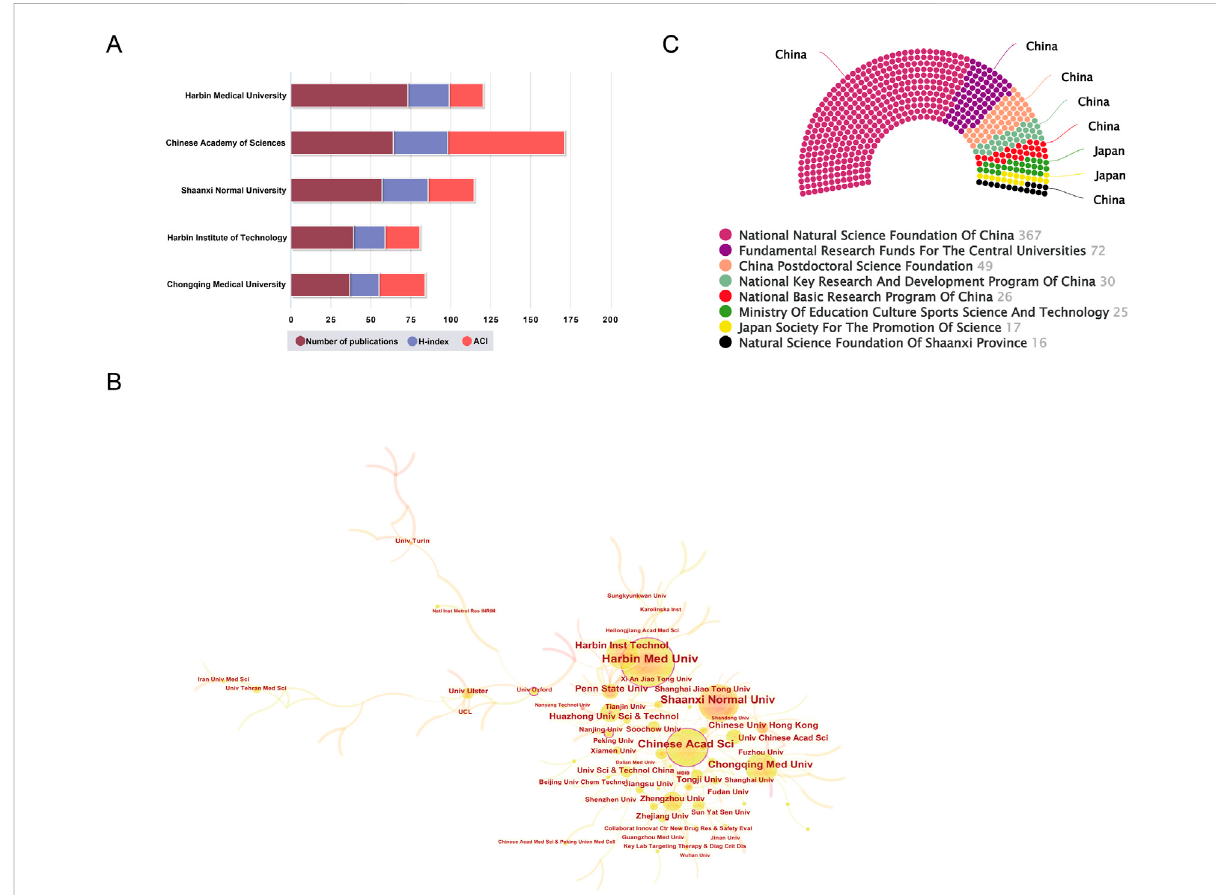
FIGURE 3 (A) The top fi ve most proli fi c institutions. (B) Institutional cooperation analysis by using CiteSpace. In this network map, each node represented an institution, and the node size represented their relative quantity of research outputs. A node with a purple circle showed that the centrality was more than .1. (C) The top eight most active funding agencies in this